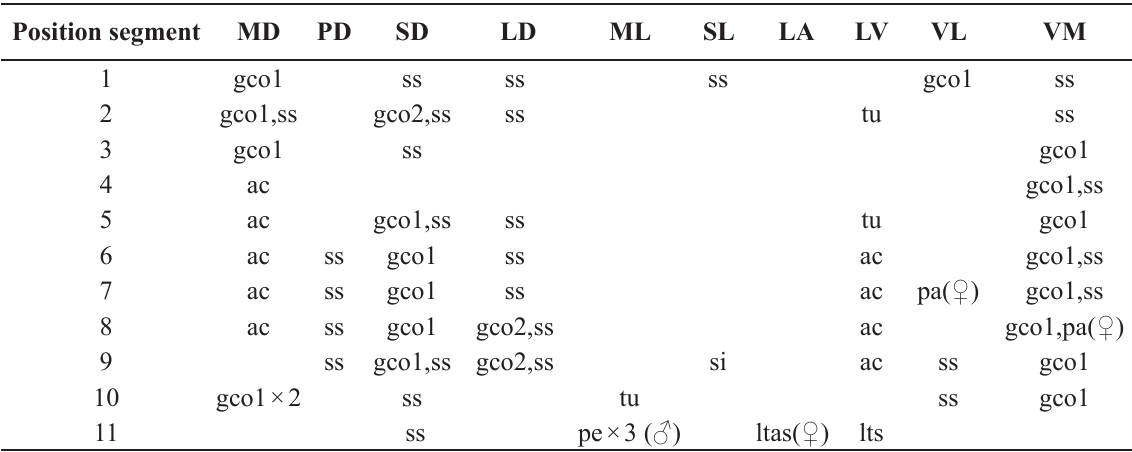
Table 25. Summary of nature and location of sensory spots, glandular cell outlets, tubes and spines arranged by series in Echinoderes sp. aff. E. lupherorum